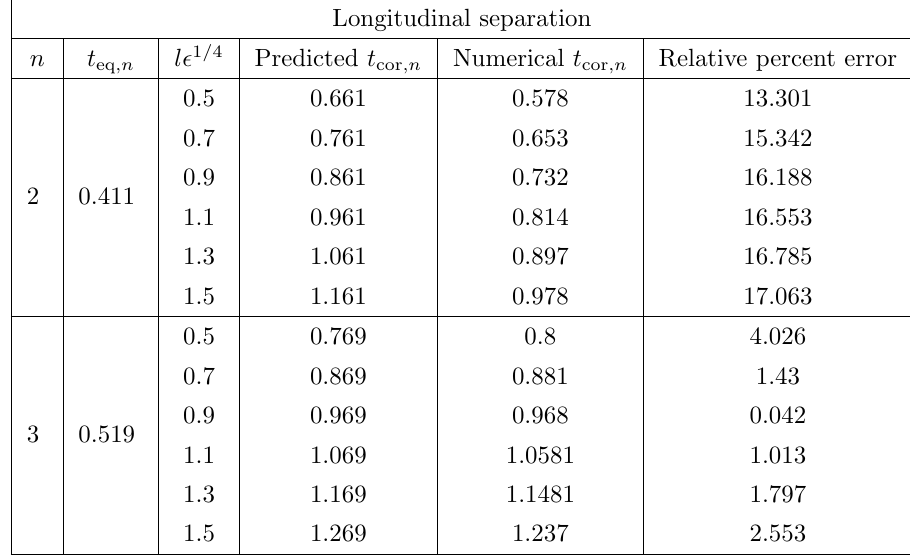
Table 4 . Example equilibrium times of the 1-point functions, t eq ;n , and 2-point functions, t cor ;n , in a thermalizing (cid:13)uid (dual to the evolution towards a Schwarzschild black brane geometry).